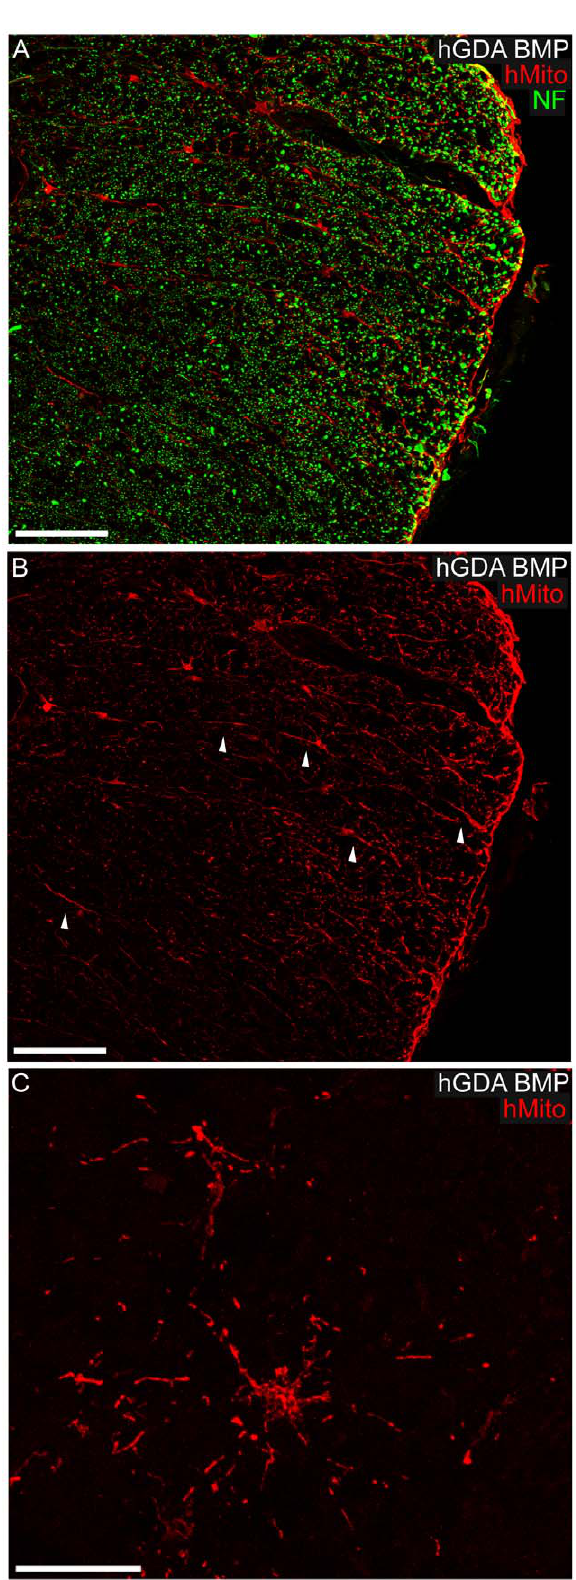
Figure 4. Migration and morphology of hGDAsBMP within DLF white matter. (A, B) High power images showing hMito + hGDAs BMP in the process of migrating and accumulating at the pial surface within lateral funniculus white matter. Note the elongated radially